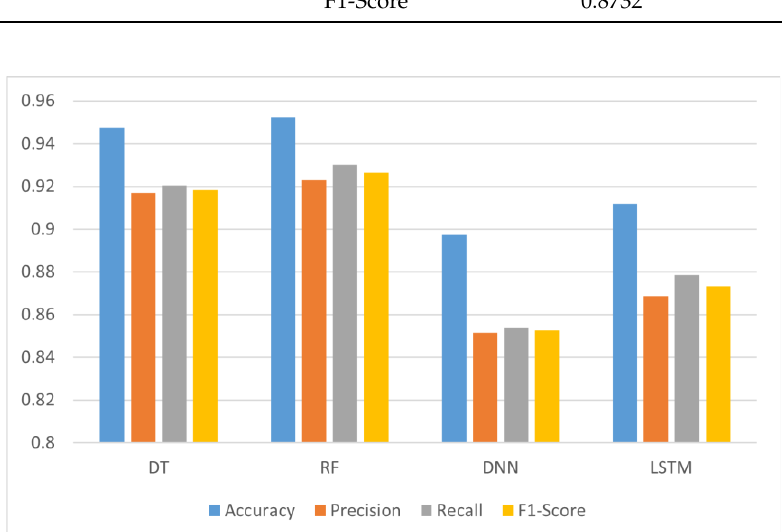
Figure 6. Values of the evaluation metrics for each candidate algorithm in setting 1.